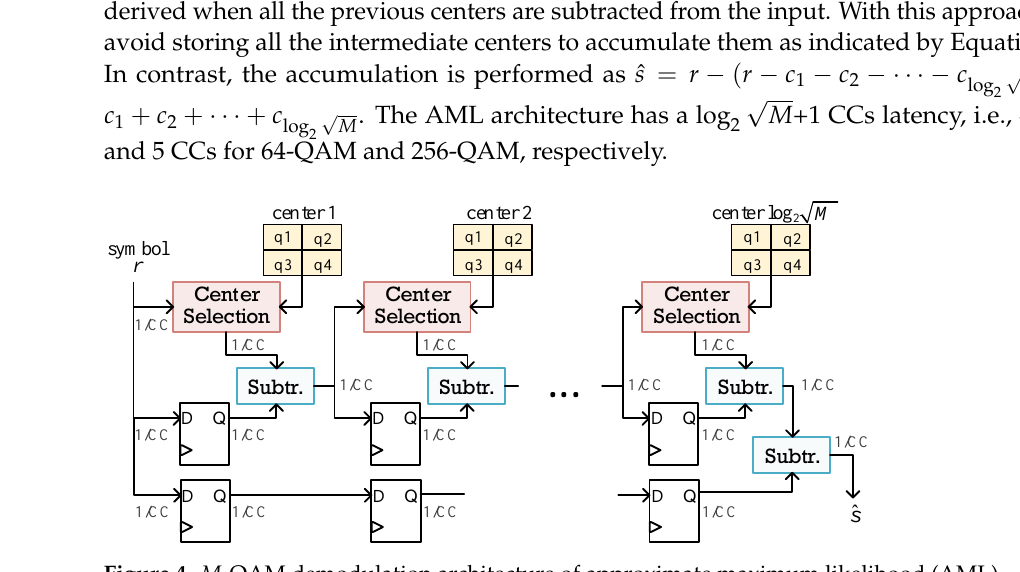
Figure 4. M -QAM demodulation architecture of approximate maximum likelihood